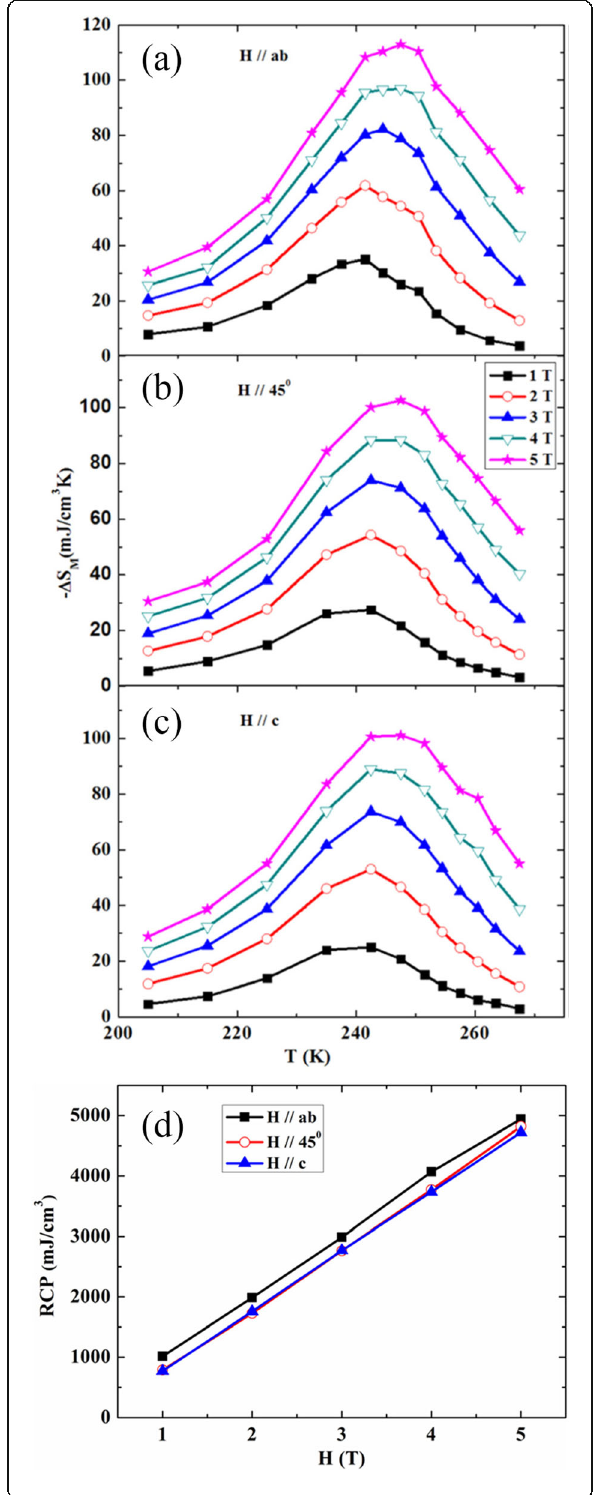
Fig. 35 a – c Magnetic entropy changes in the La 0.8 Ca 0.2 MnO 3 thin films as a function of temperature and external magnetic field in different directions. a H// ab , b H//45°, and c H// c . d Relative cooling power (RCP) of the thin film as a function of magnetic field in different field directions. Reproduced with permission of